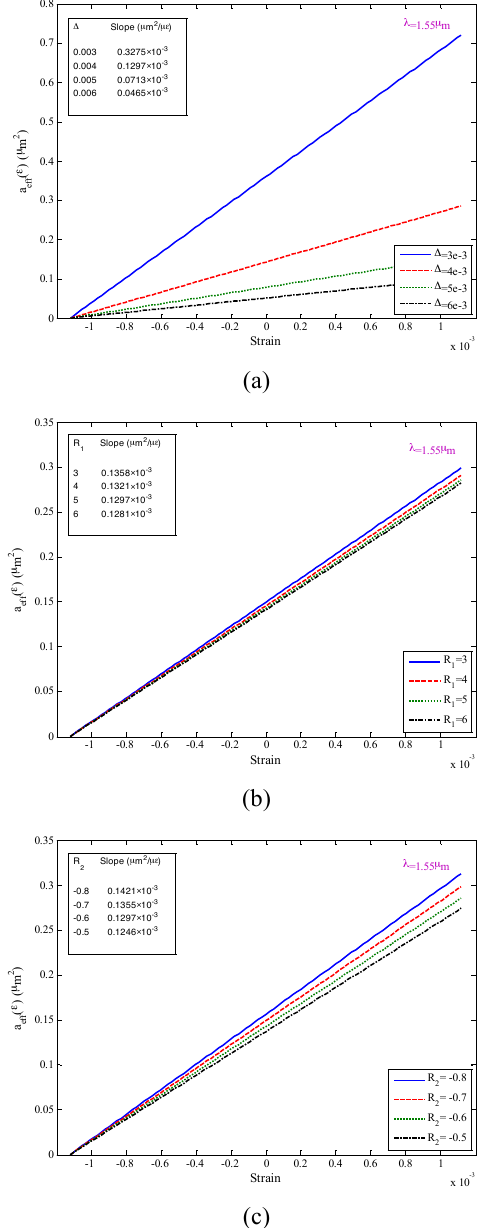
Figure 7: a parameter.